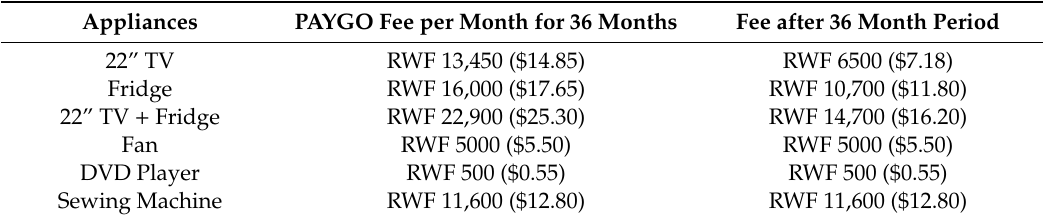
Table 3. Proposed fees for upgrading